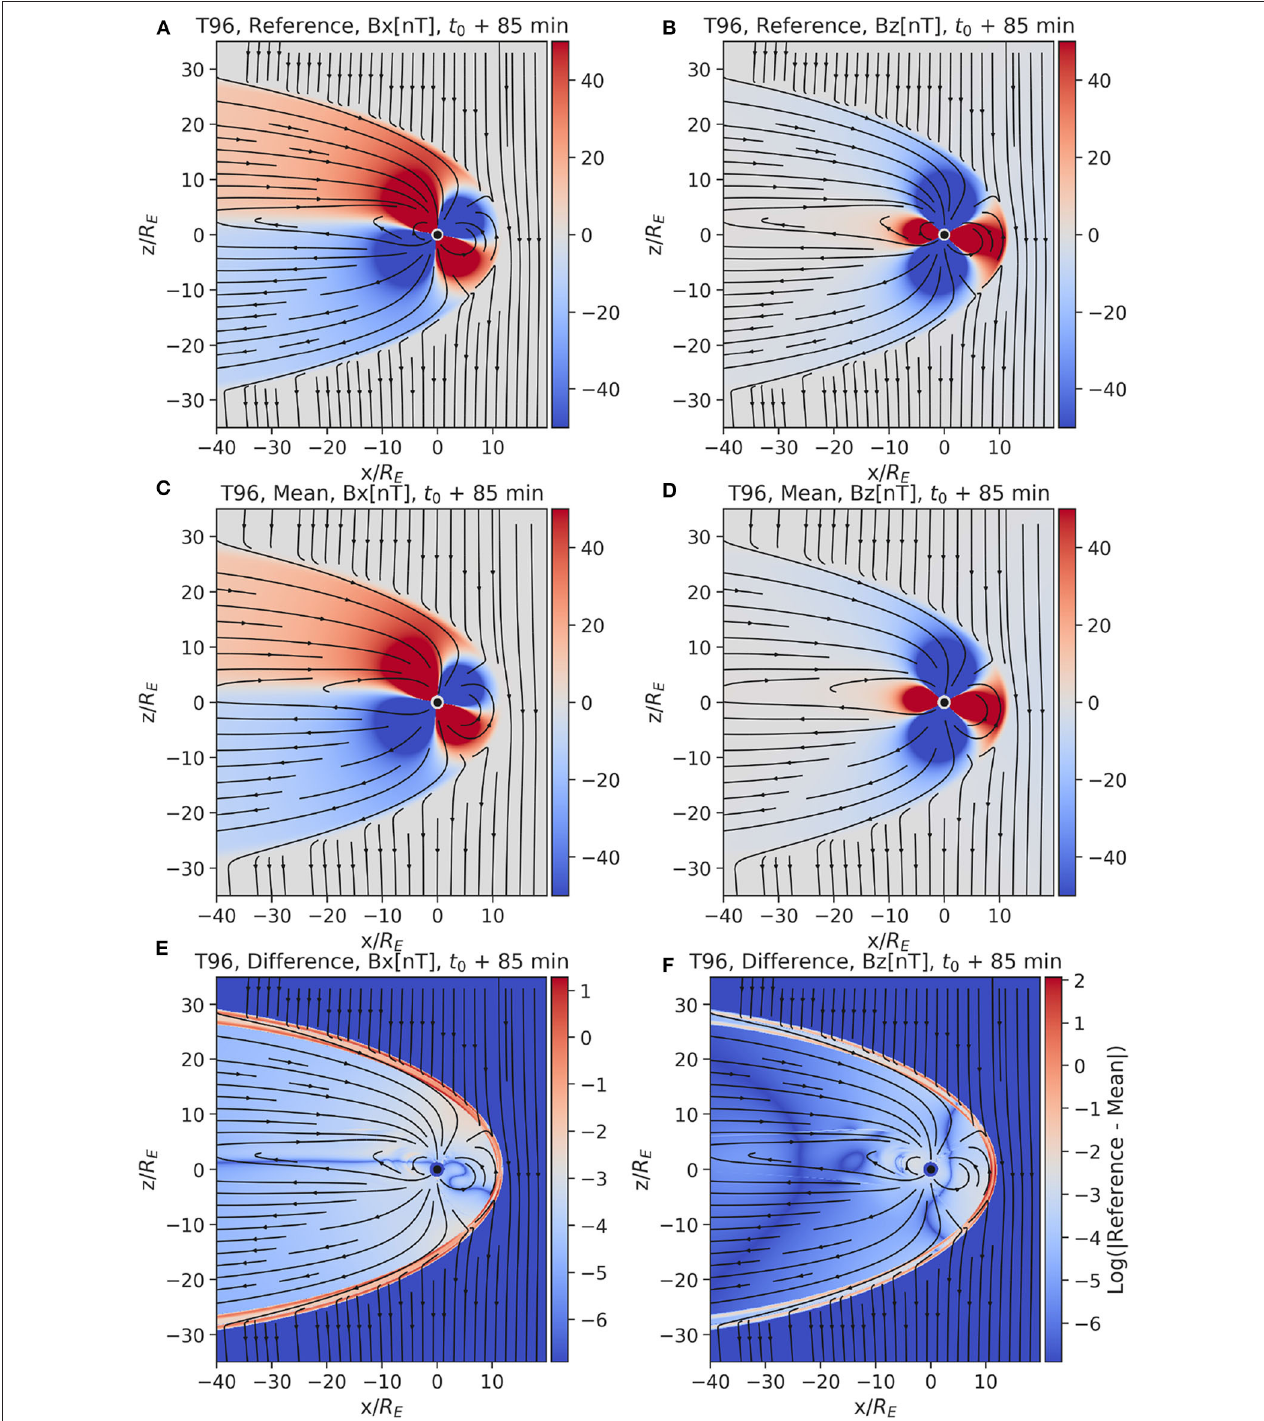
FIGURE 6 | Results from the T96 Tsyganenko model. The top row (A,B) shows the reference magnetic field ( B x and B z component respectively) at time t 0 + 85 min, with a negative IMF. The middle row (C,D) shows the ensemble mean of the same magnetic field components at the same time t 0 + 85 min. We clipped the magnetic field values to | 50 nT | , in order to make variations in the tail better visible. The last row (E,F) shows the logarithm of the absolute difference between the reference simulation and the mean of the ensemble.